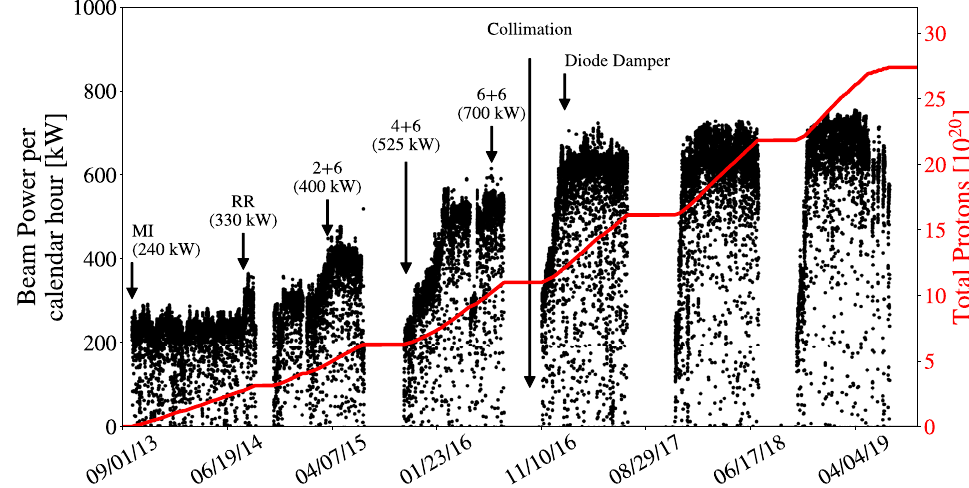
FIG. 4. The hourly beam power to NuMI and the total protons delivered since the end of the long shutdown in 2013. The beam power is initially limited to 240 kW when only the Main Injector is used. As slip-stacking in the Recycler is commissioned, the beam power is steadily increased until January 2017 when the beam power meets the design goal. If beam is also being delivered to Switchyard via resonant extraction in the Main Injector, NuMI will see a 10% decreases in beam power (630